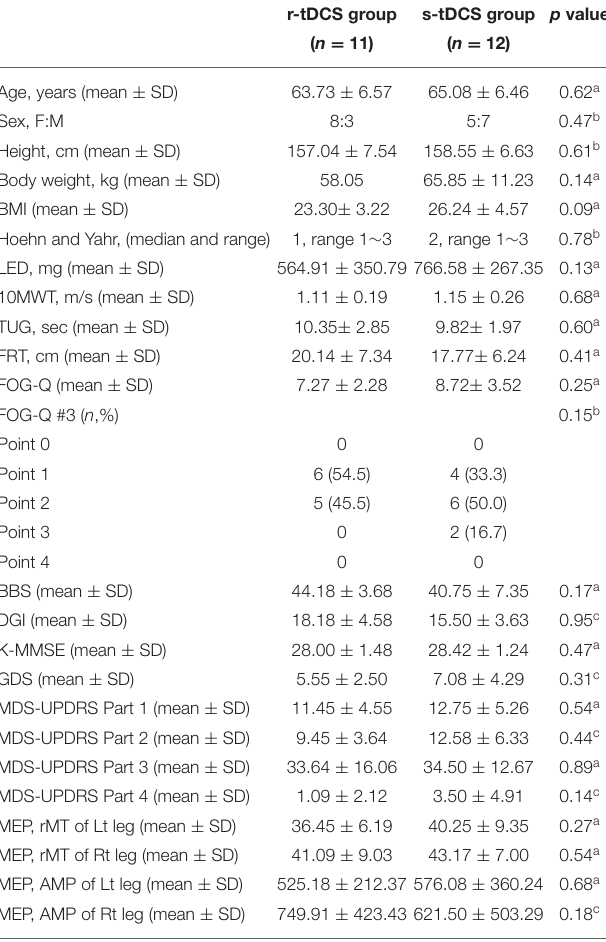
TABLE 1 | Baseline characteristics of the study